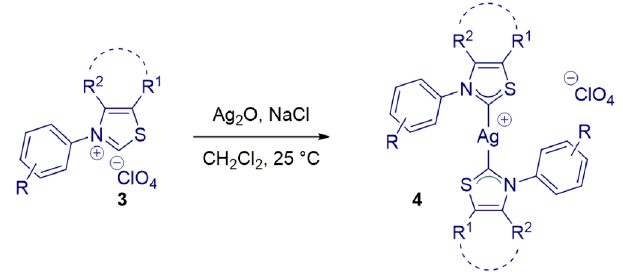
Fig. 3 Synthesis of Ag(I) complexes. Conditions: Ag 2 O (0.5 equiv), NaCl